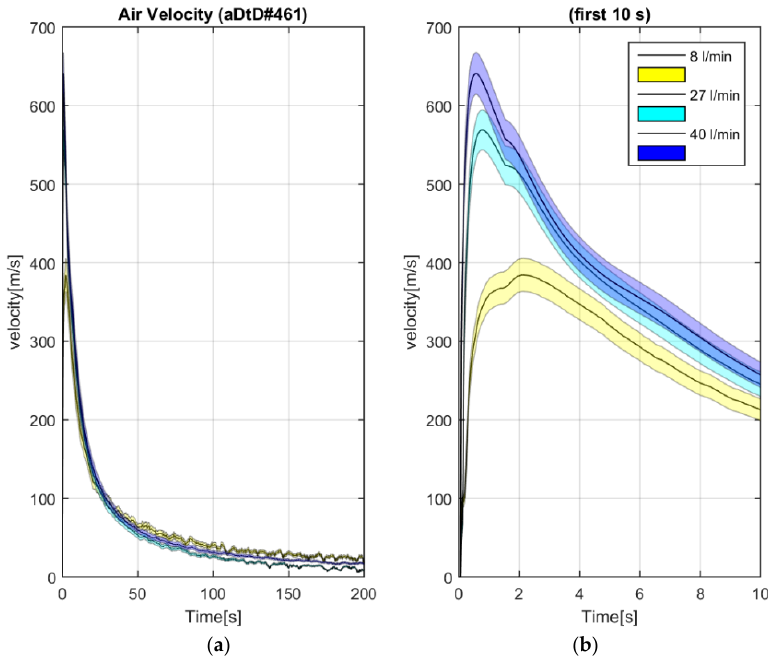
Figure 12. ( a ) Description of the velocities variation during the whole experiments. ( b ) A detail of the velocities variation in the first 10 s.